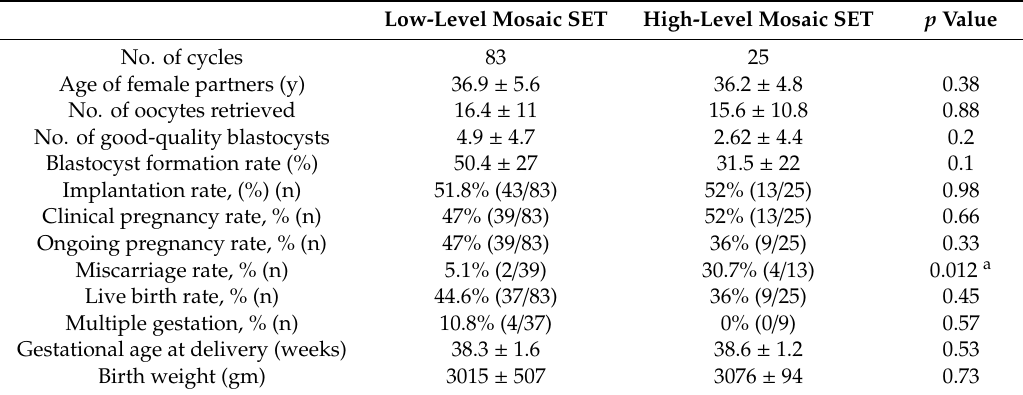
Table 1. Impact of mosaicism level on clinical outcomes after single mosaic embryo transfer.